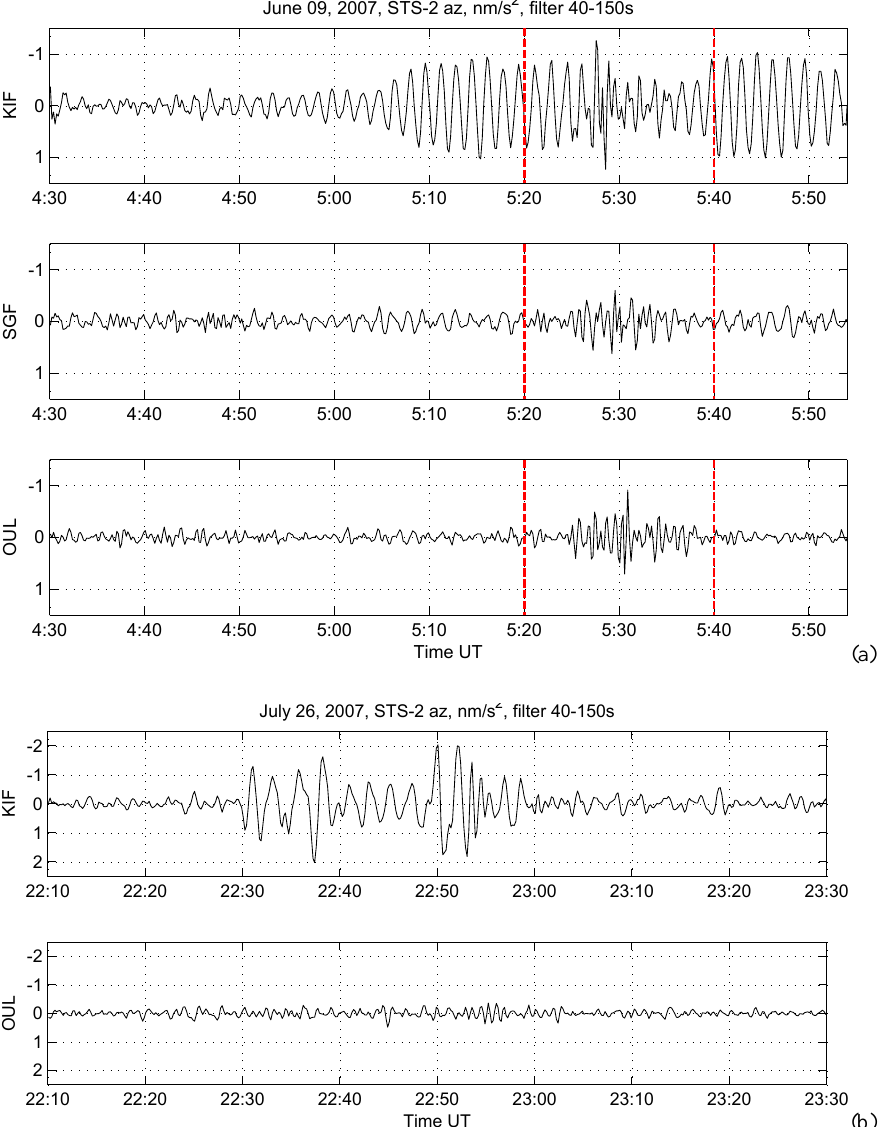
Fig. 9. (a) Geomagnetic pulsations recorded by the STS-2 seismometers at permanent seismic stations OUL, SGF and KIF for the Pc4 event on 9 June 2007. Red lines indicate time interval of glacial seismic event in Greenland (according to Nettles and Ekstr¨om, 2010). (b) Geo- magnetic pulsations recorded by the STS-2 seismometers at permanent seismic stations OUL and KIF for the Pi2 event on 26 July